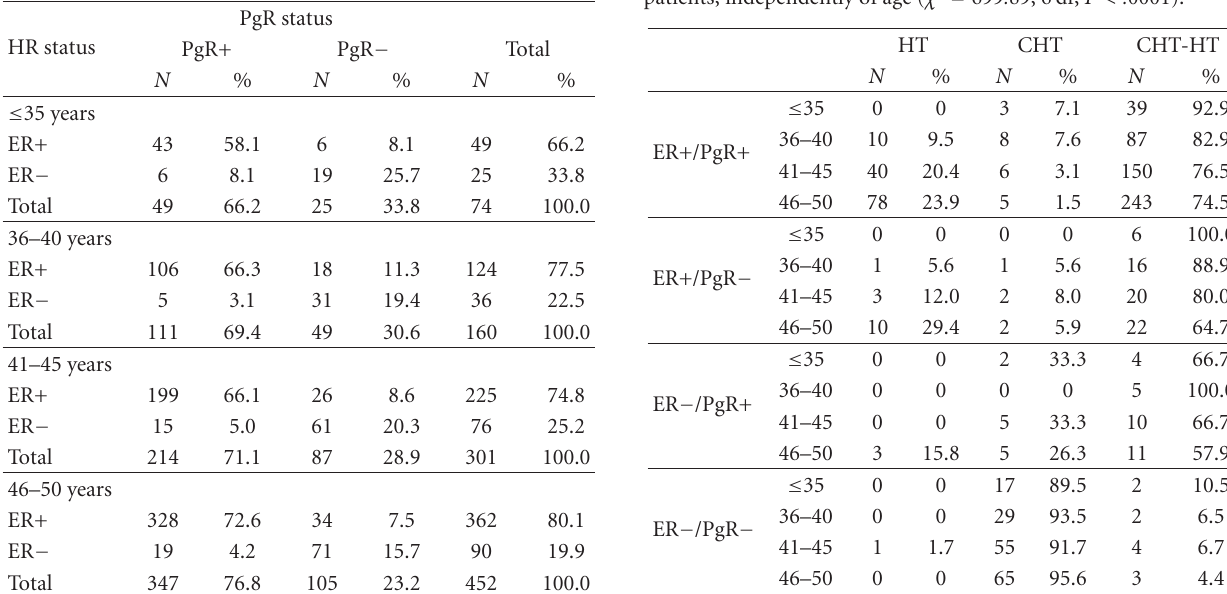
Table 6: Adjuvant treatment according to hormone receptor status and age. Endocrine therapy is more frequently administered in